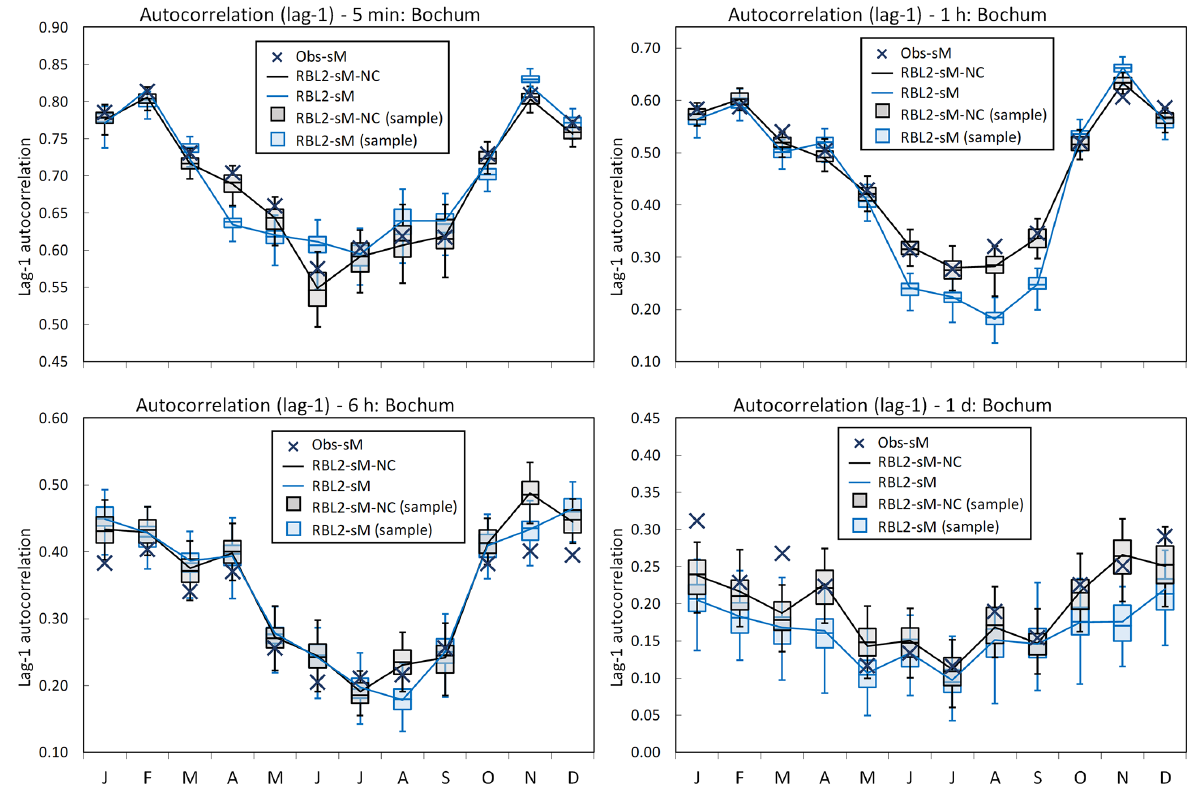
Figure 9. Lag-1 autocorrelation by month at Bochum: the observed vs. the fitted lag-1 autocorrelation using the RBL2 models with the original and the new solution spaces of α (RBL2-sM, light blue lines and boxplots; RBL2-sM-NC, black lines and boxplots).